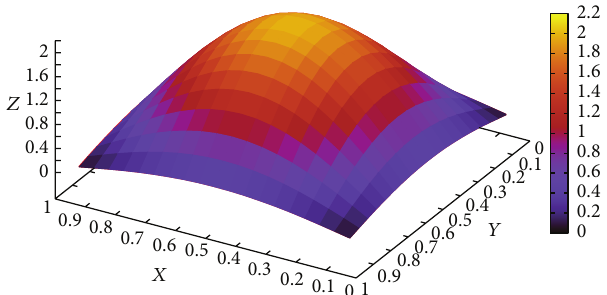
Figure 5: The approximation solution of (7) when 𝛼 = 0.4 and 𝑡 = 1.0 .